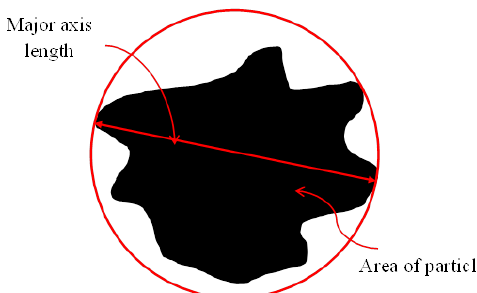
Figure 5. Schematic representation of the roundness shape